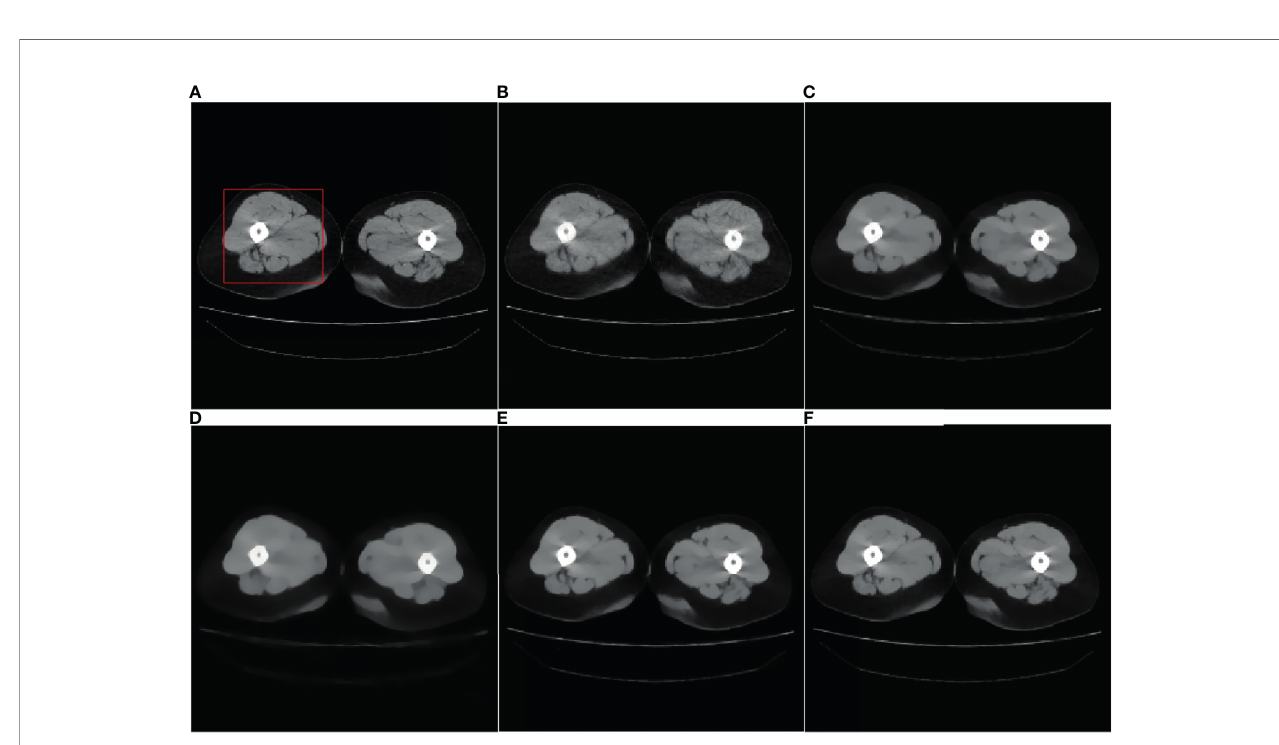
FIGURE 5 | 260th slice reconstruction result: (A) reference image; (B) SART; (C) ASD-POCS; (D) SART-TV; (E) TpV; (F) TpV-GIF.